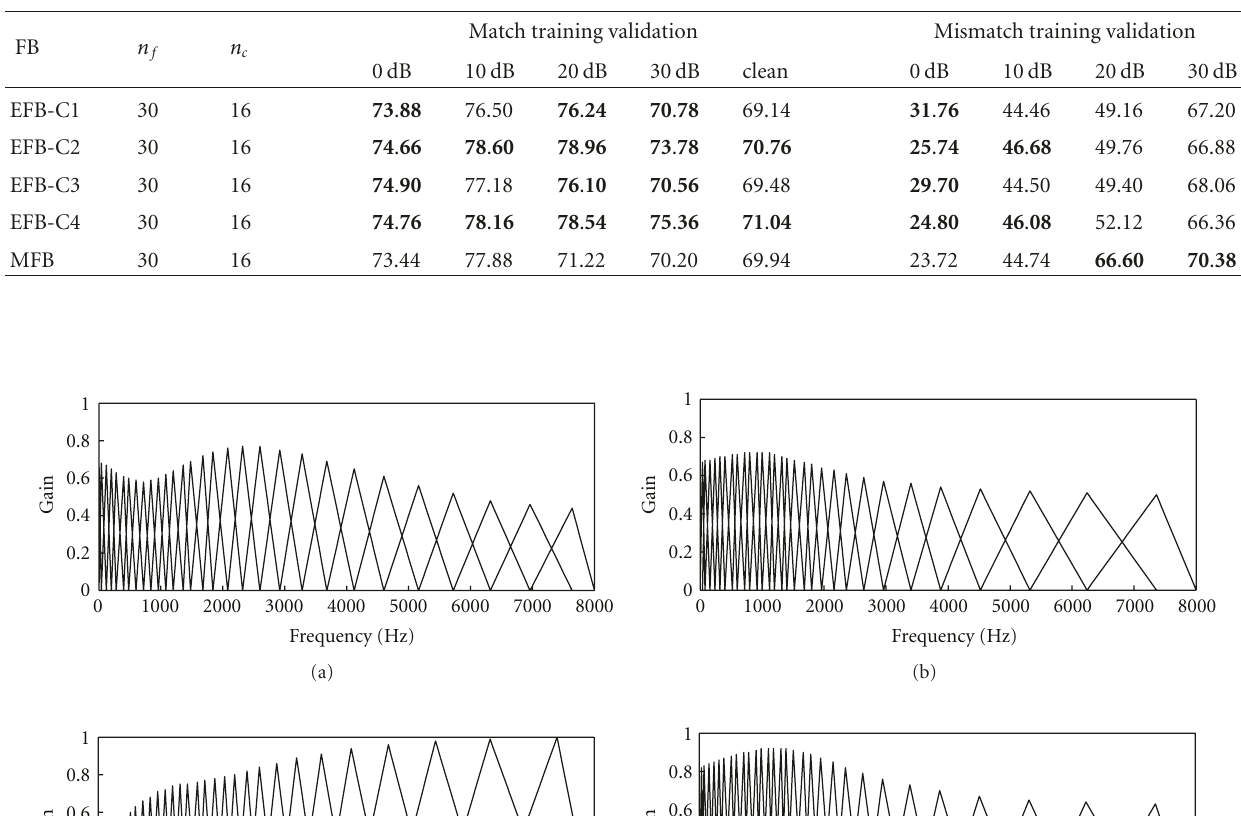
Table 3: Averaged validation results for phoneme recognition (shown in percent). Filterbanks obtained from the optimization of filter center frequency and filter gain values, and using noisy signals.